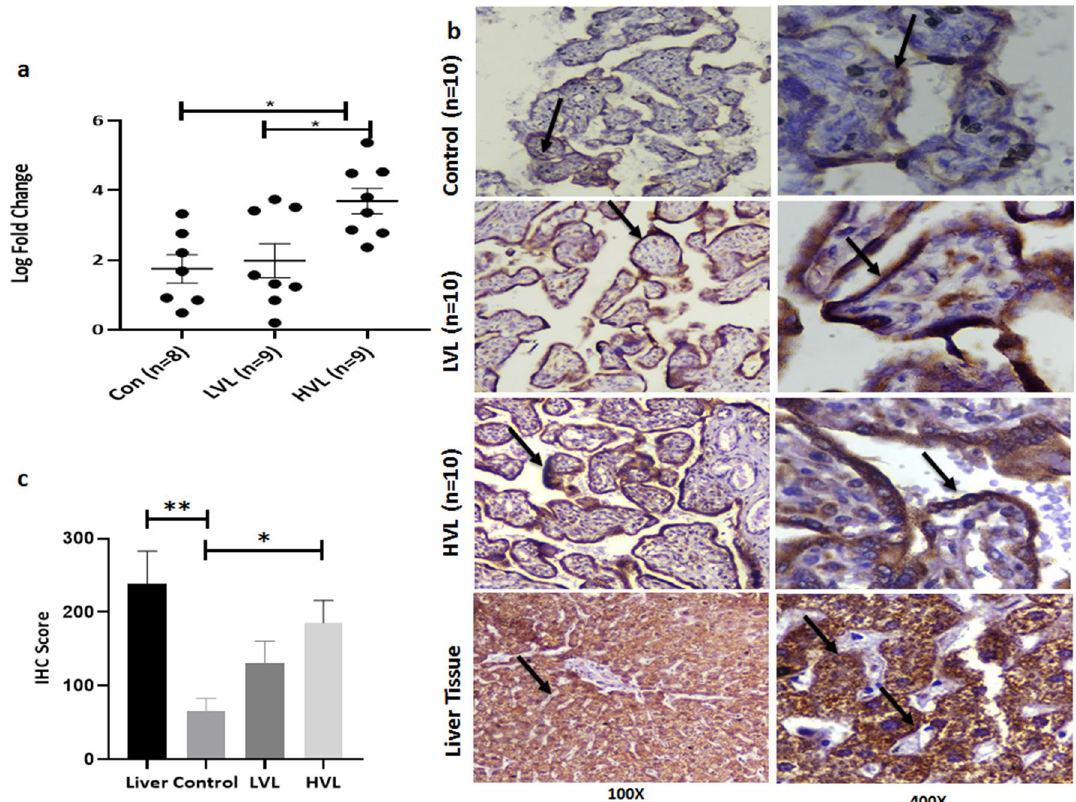
Figure 5. Expression of NTCP in placenta. ( a ) NTCP expression in placenta samples from various groups was measured using qRT-PCR. It was significantly up regulated in HVL group when compared with control group (HVL 3.69 ± 0.36 vs. Control 1.74 ± 0.40, p = 0.0117; * < 0.05) or LVL group (HVL 3.69 ± 0.36 vs. LVL 1.98 ± 0.48, p = 0.022; * < 0.05) but was no significant difference was found between LVL and Control group (LVL 1.98 ± 0.48 vs. Control 1.74 ± 0.40, p = 0.9213; * < 0.0332). ( b ) Representative figure of expression of NTCP in placenta through Immunohistochemistry, weak cytoplasmic staining in control, moderate to strong membranous and cytoplasmic staining in LVL and HVL group was observed. Strong membranous and cytoplasmic staining of non-pathological liver tissue was served as positive control. ( c ) IHC Scores were plotted against log of HBV DNA viral load (IU/ml) There was a significant difference between liver and control group (238 ± 44.88 vs. 65.5 ± 17.36, p = 0.0064; ** < 0.005) HVL and control group (HVL 185.5 ± 30.72 vs. Control 65.5 ± 17.36, p = 0.011; * < 0.05). Whereas, no significant difference was obtained between HVL and LVL groups (HVL 185.5 ± 9.71 vs. LVL 130.5 ± 30.45, p = 0.333) and LVL and control group (LVL 130.5 ± 30.45 vs. Control